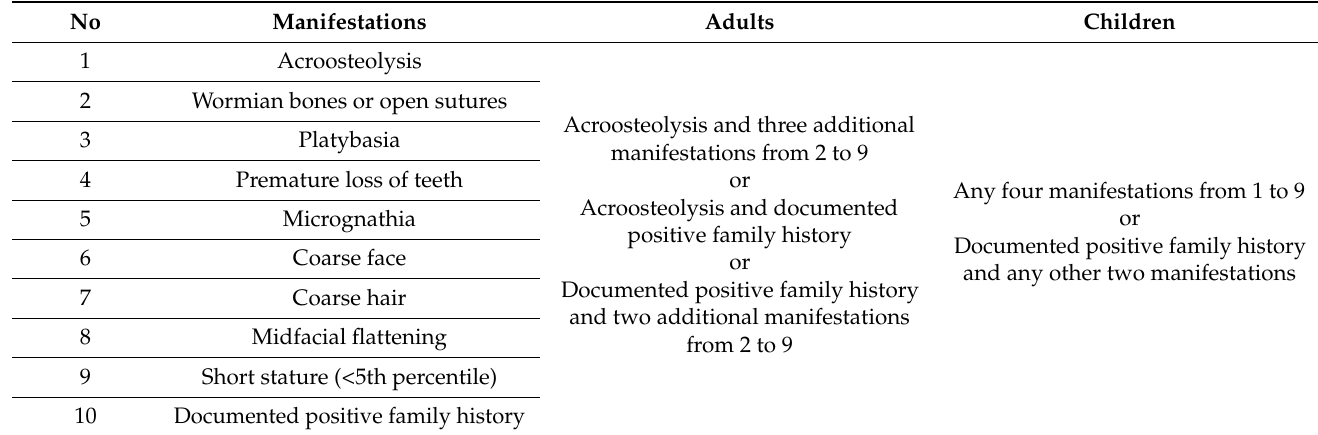
Table 1. Brennan and Pauli criteria of Hajdu-Cheney